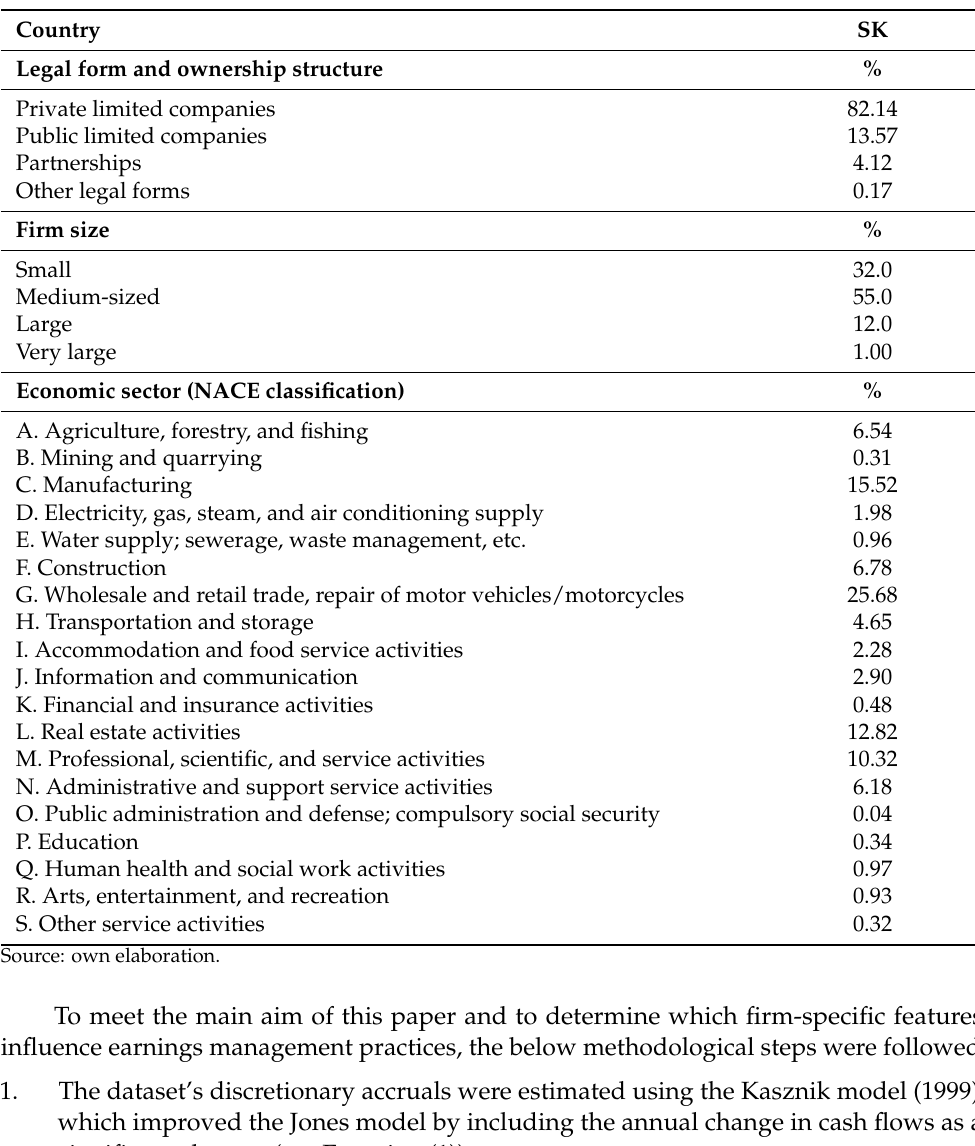
Table 1. Firm specific characteristics of the